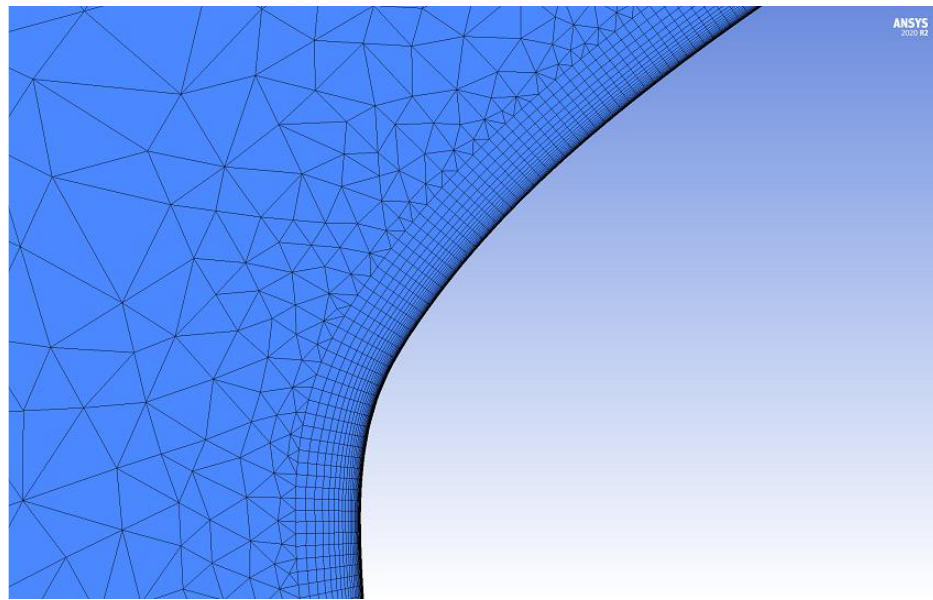
Figure 5. A hybrid grid on an airfoil leading edge. @Fahed